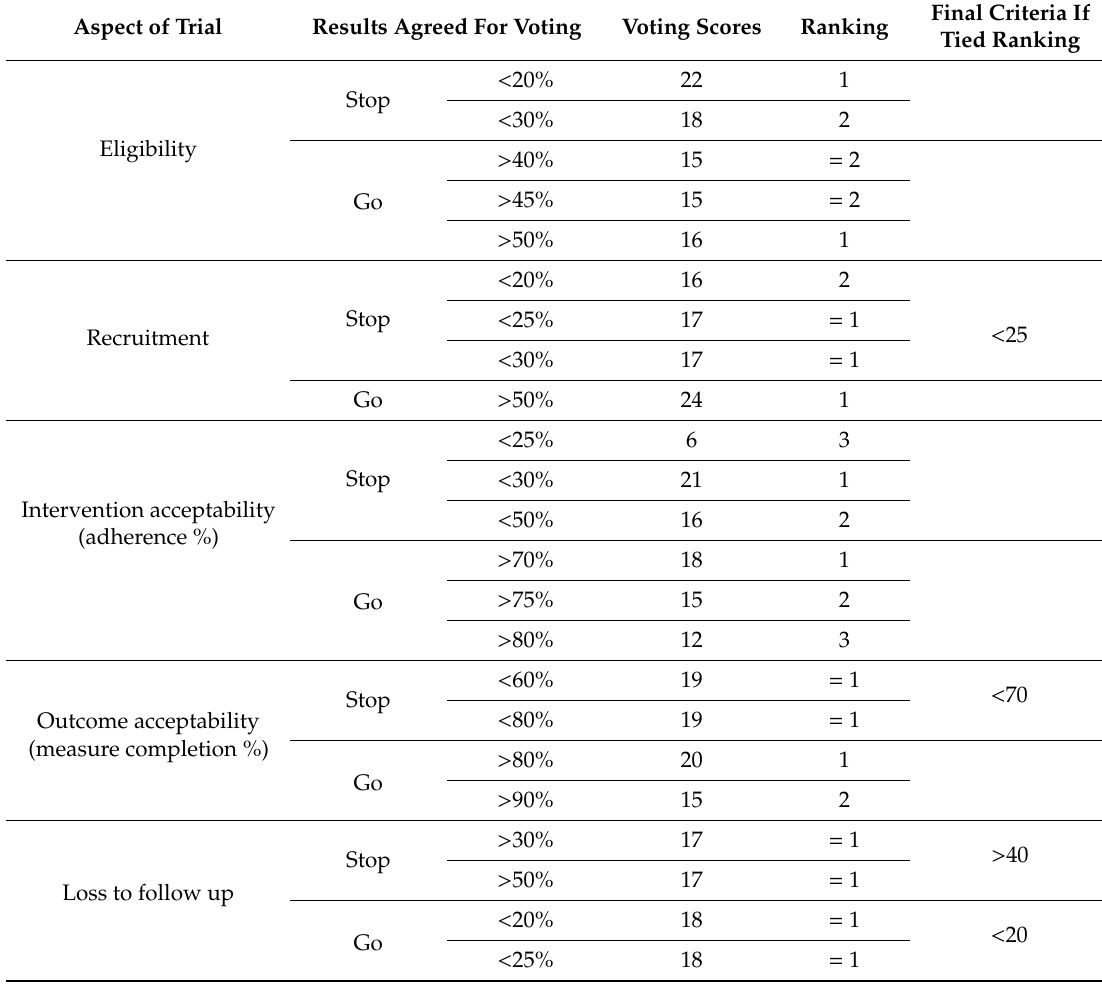
Table 5. Scores and ranking of condensed progression criteria. Progression criteria are expressed as a percentage. A maximum score of 24 was possible during the voting